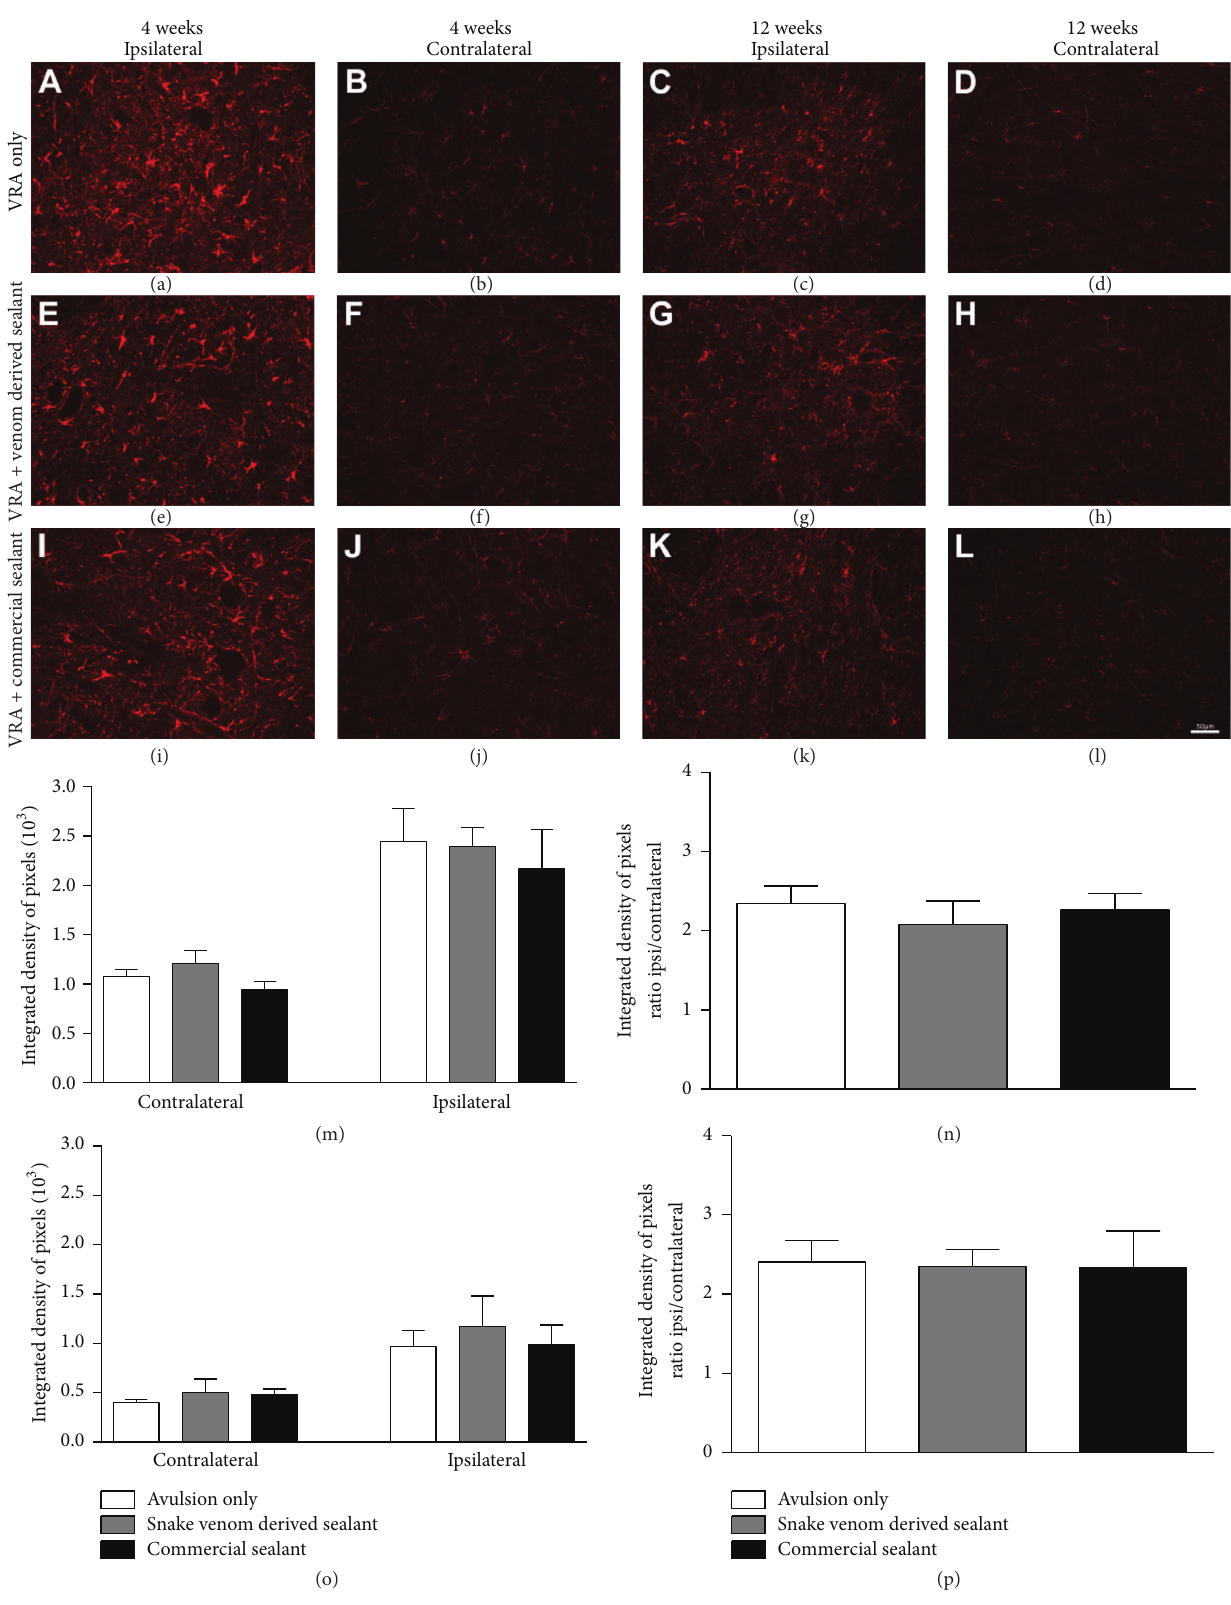
Figure 3: Immunohistochemical analysis of the spinal cord ventral horn stained with glial fibrillary acid protein (GFAP), 4 and 12 weeks following ventral root avulsion and repair. No significantly further increase in astrogliosis after reimplantation was observed. (a-b, e-f, and i-j) Ipsilateral and contralateral sides, 4 weeks after lesion. (c-d, g-h, and k-l) Ipsilateral and contralateral sides, 12 weeks after lesion. (m) Mean integrated density of pixels obtained ipsi and contralateral to the lesion side, 4 weeks after injury. (n) The ratio IL/CL (ipsi/contralateral sides) of the integrated density of pixels at lamina IX, 4 weeks after lesion. (o) Mean integrated density of pixels obtained ipsi and contralateral to the lesion side, 12 weeks after injury. (p) The ratio IL/CL (ipsi/contralateral sides) of the integrated density of pixels at lamina IX, 12 weeks after lesion. Scale bar = 50 𝜇 m. Mean ±